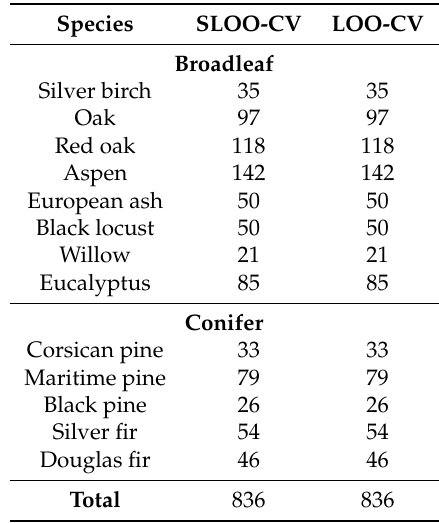
Table A4. Number of training pixels for each cross-validation method. For both methods, value per species is the mean from the 50-folds. The split between test and train set is exactly the same for each